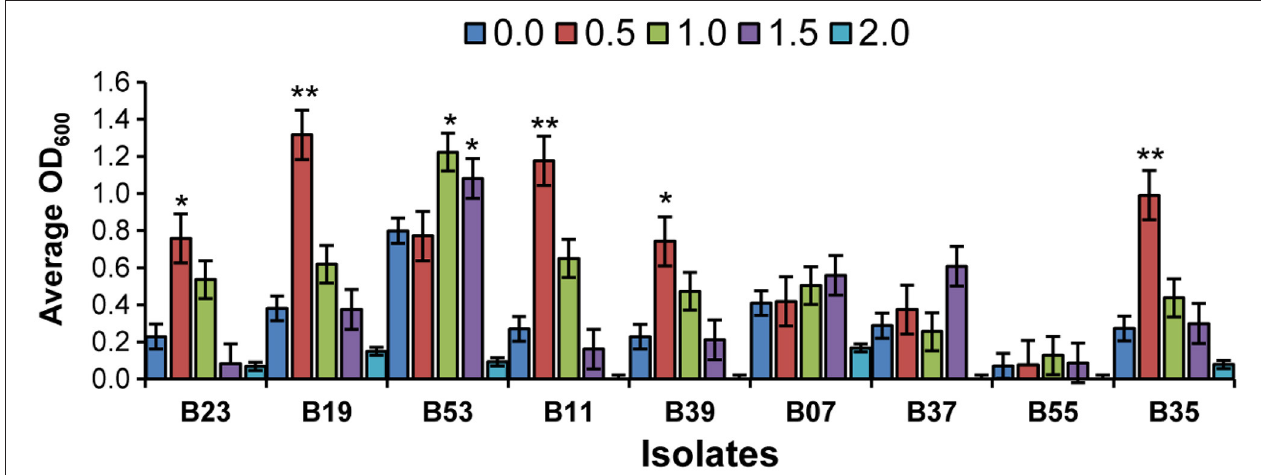
FIGURE 2 | Effects of salinity stress on the selected bacteria in broth cultures at OD 600. Bar chart represents means ± standard error (SE). Asterisk on the top of each error bar depicts significant difference of the OD 600 among the different salt concentration in a specific isolate (One-way ANOVA: * P < 0.05, ** P <